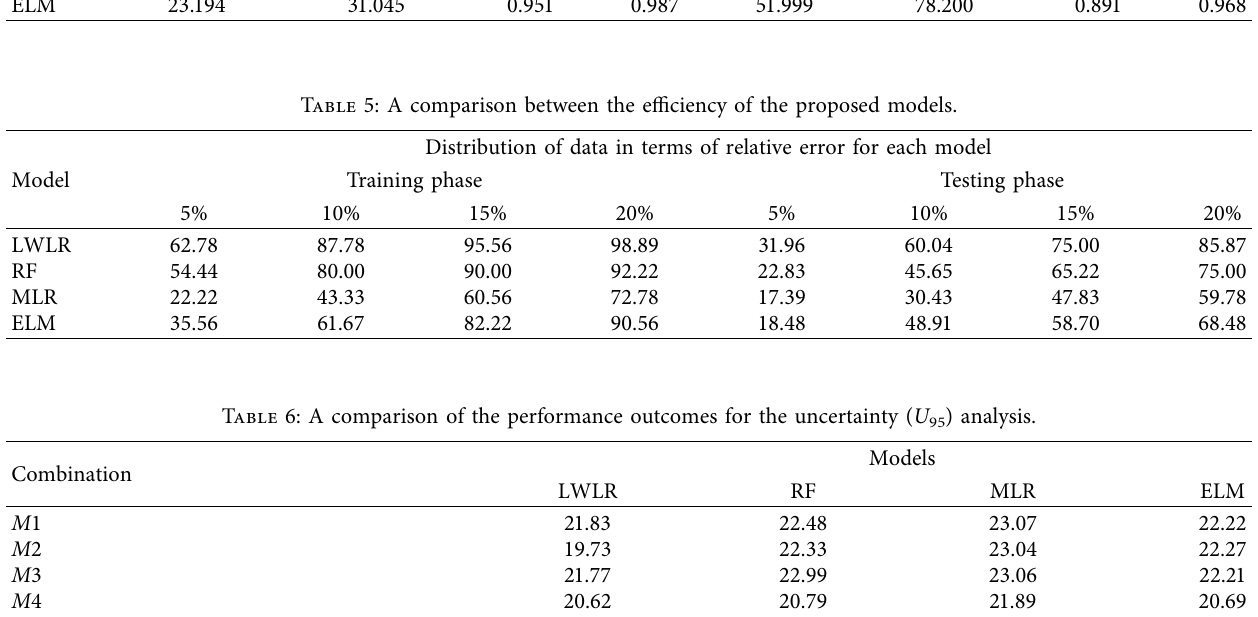
Table 4: The statistical description of the proposed models: first scenario. Model